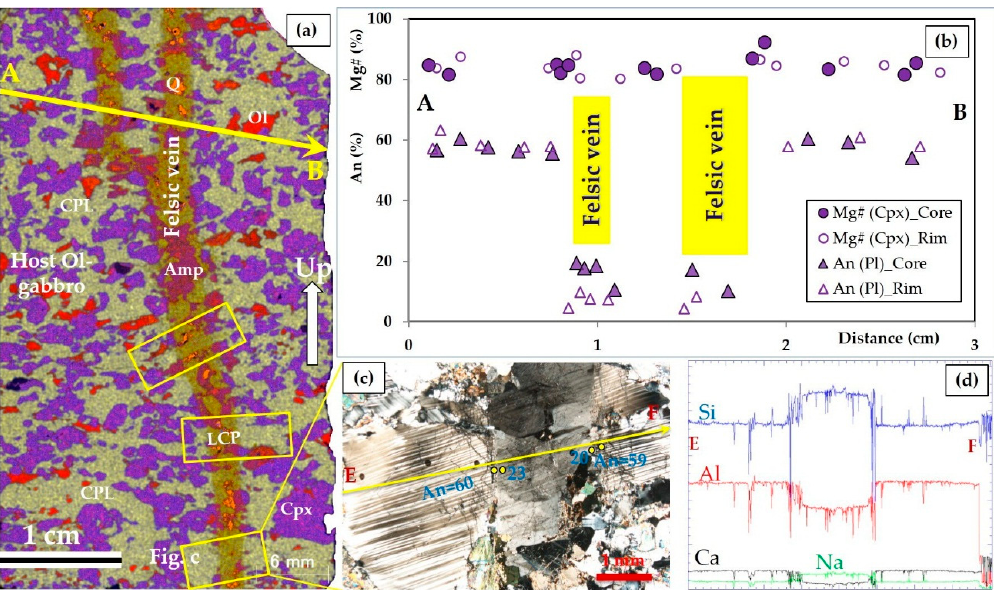
Figure 5. Host olivine gabbro-felsic rock interaction, sample 66R5, 1–7 cm. ( a ) Phases X-ray mapping image of the whole thin section; notice the continuous texture between the felsic vein and the host olivine gabbro; ( b ) geochemical profile across felsic vein. ( c ) Coarse grain of calcic plagioclase (CPL) was partly replaced by less calcic plagioclase (LCP). ( d ) Semi-quantitative chemical profile of plagioclase shown in ( c ).